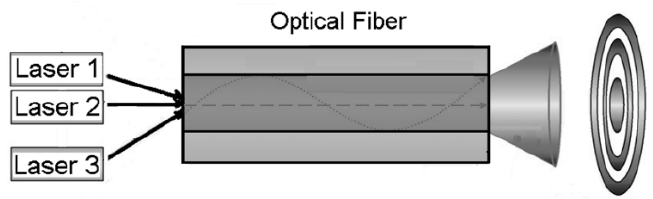
Figure 1. A schematic of a three-channel SDM system, consisting of a center disk and two concentric rings.